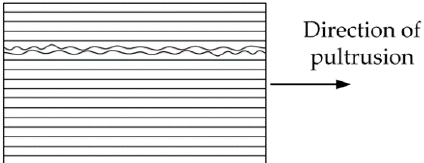
Figure 27. Random (stochastic distributed) waviness in pultrusion direction due to insufficient tow tension.